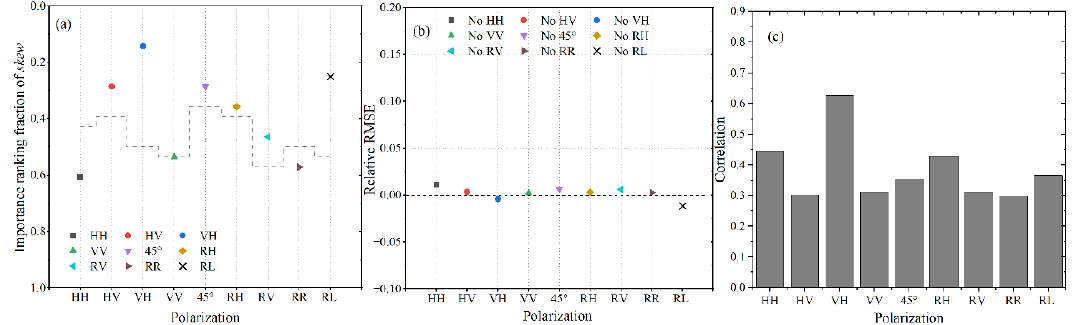
Figure 15. The importance of cvar to SWH retrieval from combined-polarization models. ( a ) The importance ranking of cvar provided by XGBoost models, normalized to the range of 0 – 1. ( b ) The effect of removing cvar on the SWH estimation from different polarized models. The red pentagrams represent the relative RMSE corresponding to the removal of cvar -terms in the combined-polarization models.